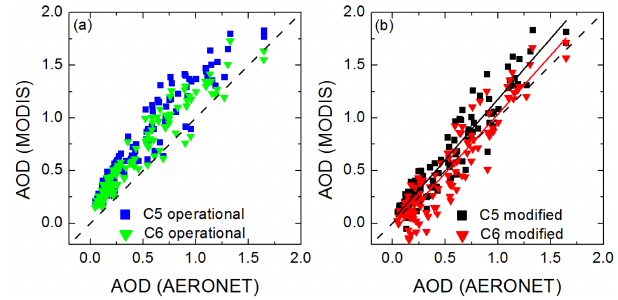
Figure 5. Scatter plot of AOD retrieved from MODIS data using (a) the operational and (b) modified Collections 5 and 6 method and the AERONET data for Beijing. The dashed line marks the 1 : 1